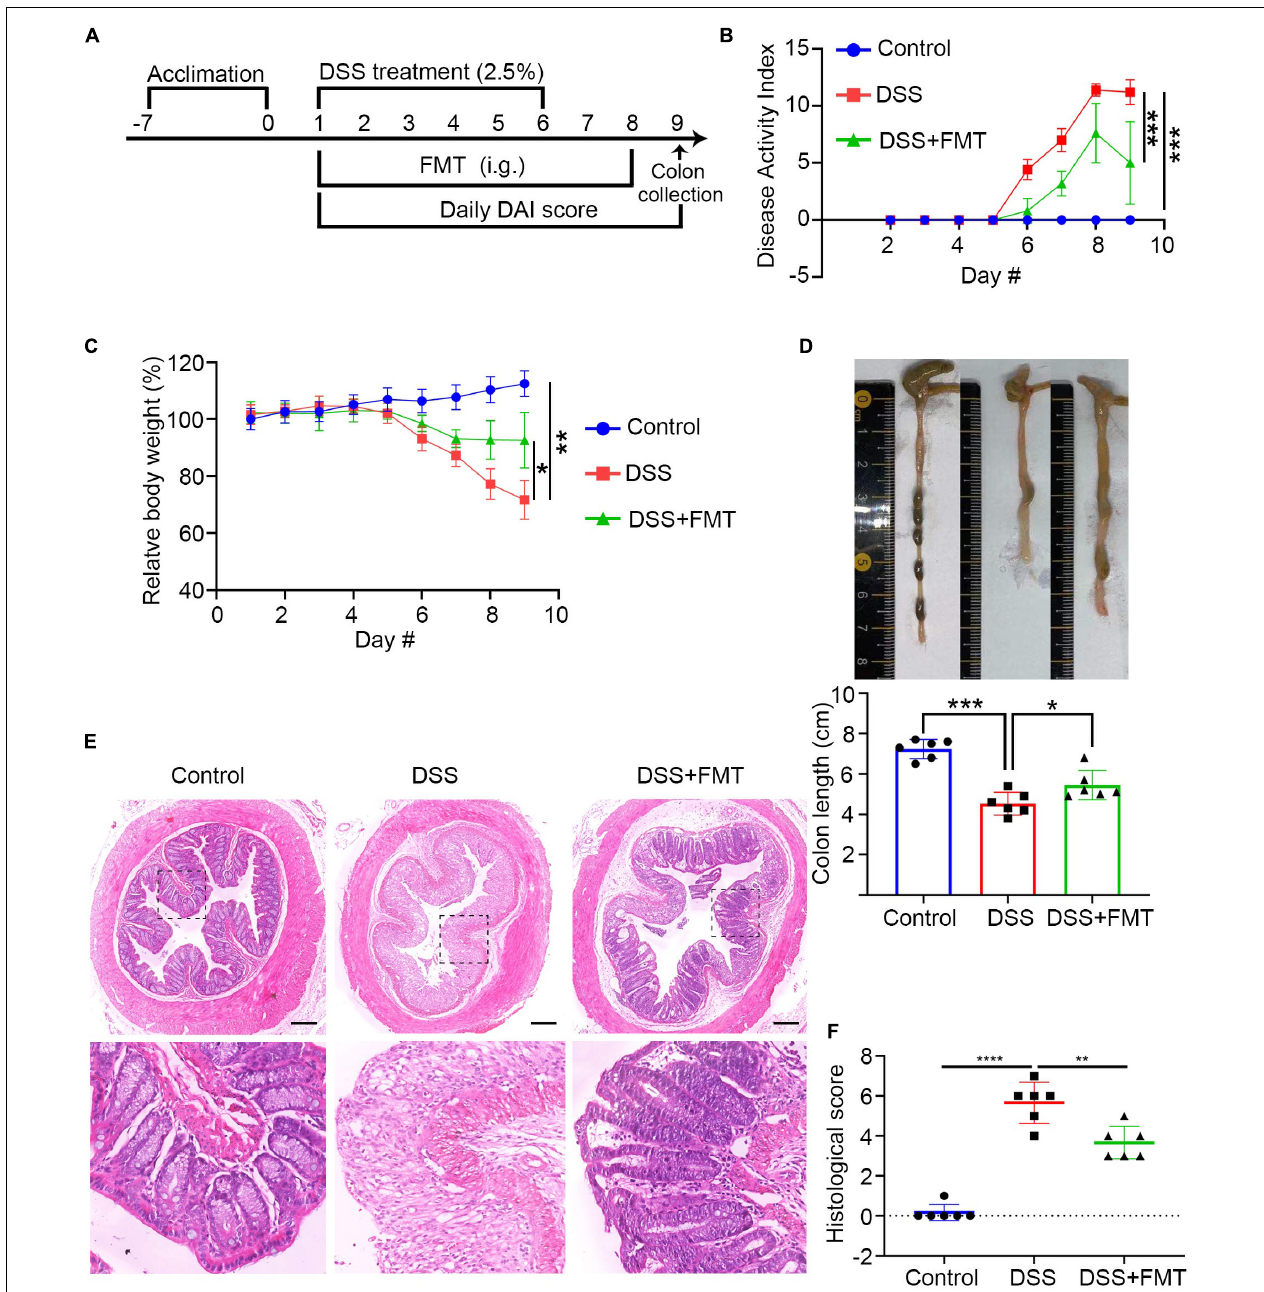
FIGURE 7 | FMT with the gut microbiota from donor 3 or mice significantly ameliorates clinical symptoms and inflammation in colitis mice. BALB/c mice were randomized and fed with normal water as the control or water containing 2.5% DSS to induce colitis. The control and some DSS-fed mice (DSS group, n = 6) were fed with PBS, whereas other DSS-fed mice were fed with fresh human or microbiota as the DSS + FMT group ( n = 6 per group). (A) Schematic diagram of the experimental design. (B) The dynamics of Disease Activity Index (DAI) in each group. (C) The relative body weight in each group. (D) Mouse colon lengths in each group. (E) H&E. (F) Histology of colonic tissue score in each group. Data are individual means or the mean ± SD of each group from three separate experiments. * p < 0.05, ** p < 0.01, *** p < 0.001, **** p <